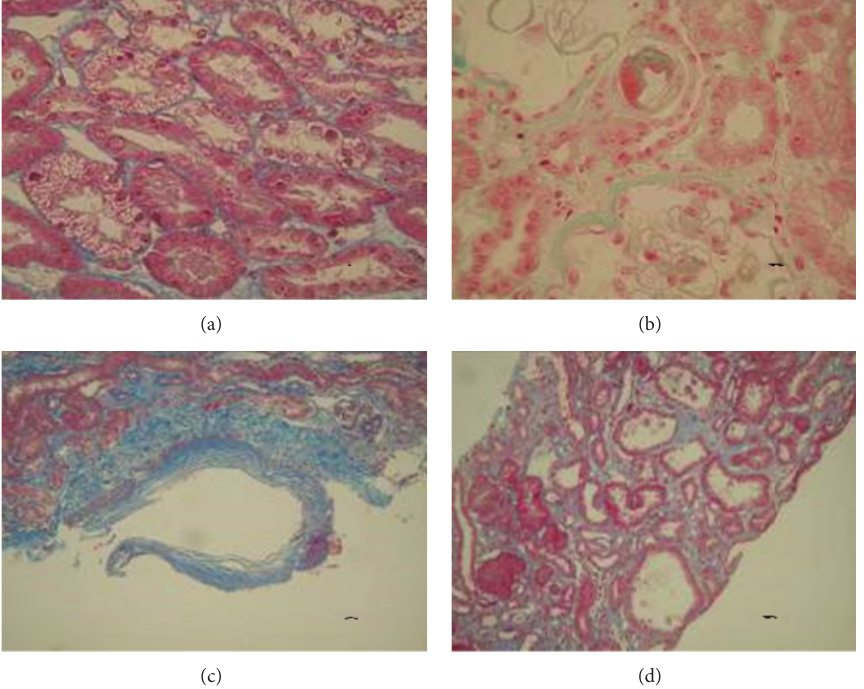
Figure 1: Discovering the latent pathological changes in elder donor kidney by Time-Zero Renal Biopsy. (a) Tubular cavity degeneration. (b) Capillary arteriolar pathological changes. (c) Intimal thickening and arteriolosclerosis. (d) Focal interstitial